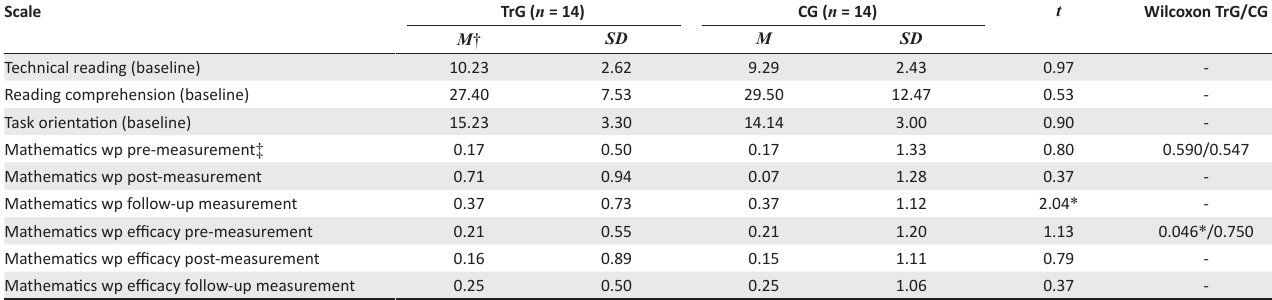
TABLE 2: Means and standard deviations at different measurement time points by group. Scale